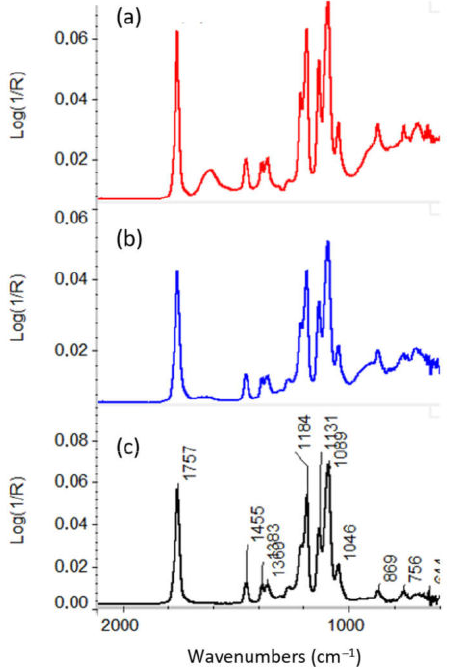
Figure 7. ATR-FTIRspectra of PLLA fibres with ( a ) nominally 30 nm Al 2 O 3 (TMA + O 3 ) ALD coating (red) ( b ) nominally 30 nm Al 2 O 3 (TMA + H 2 O) ALD coating (blue), and ( c ) uncoated fibres (black).